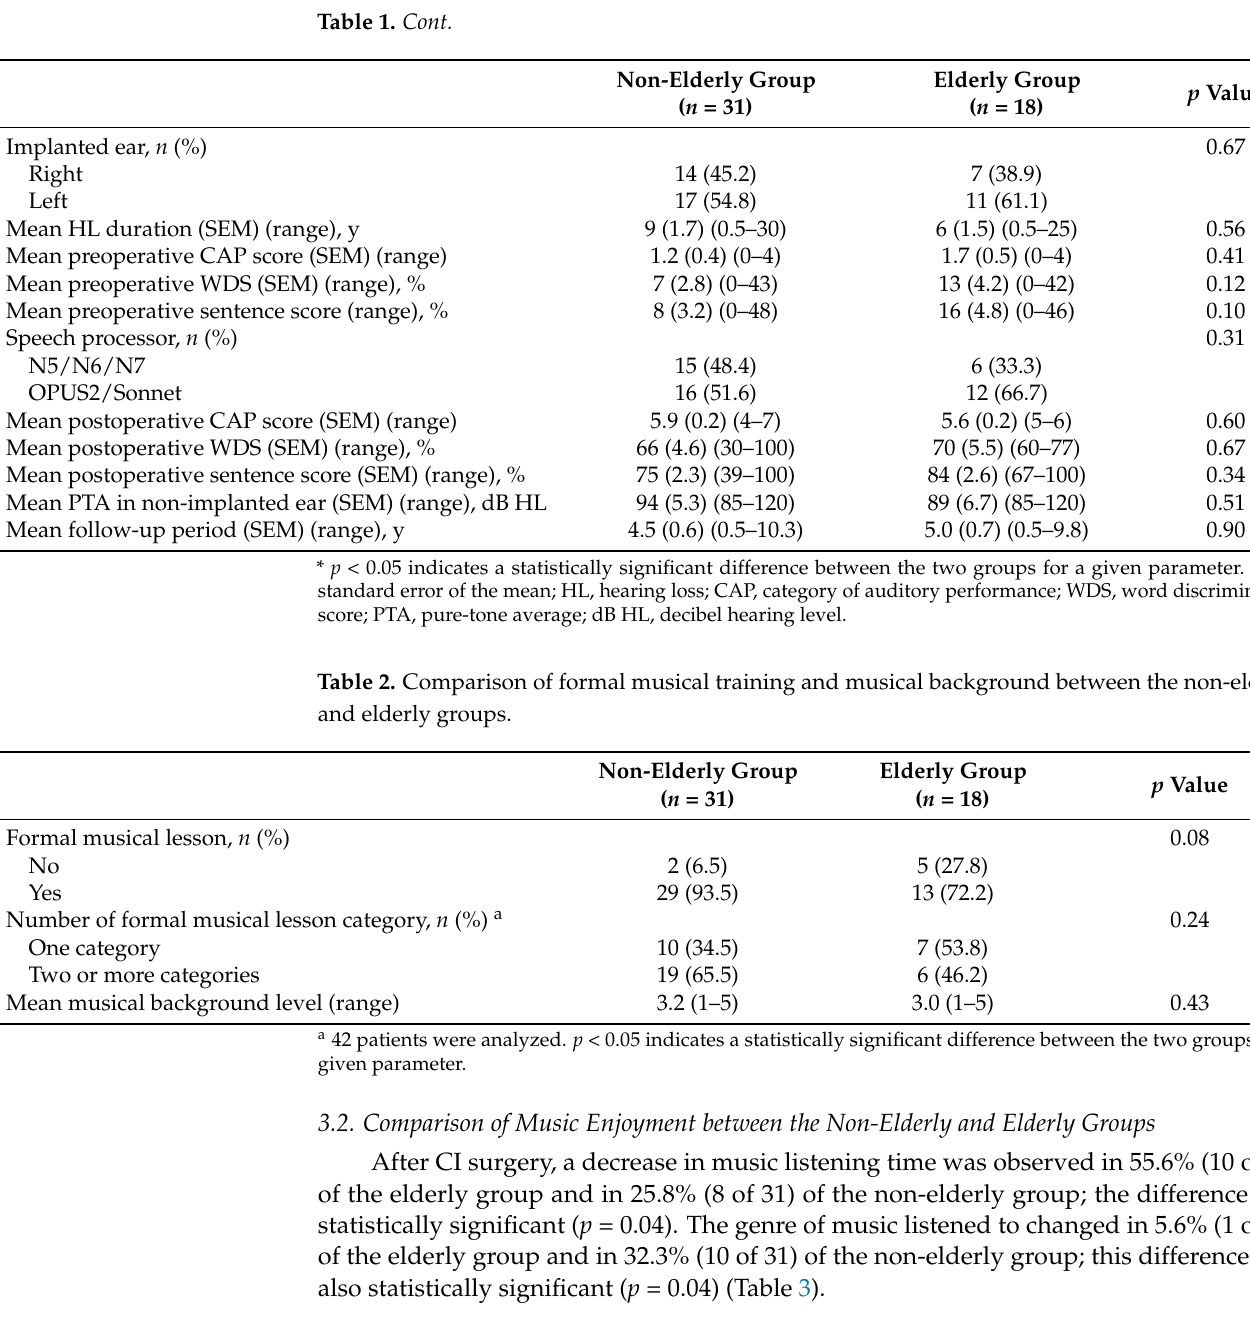
Table 3. Comparison of changes in music listening time and music genre between the